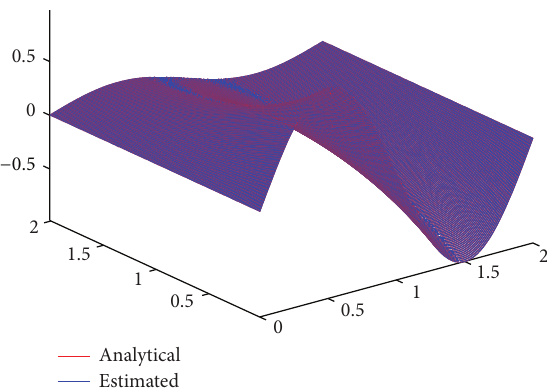
Figure 3: Theoretical solution (red color) and numerical solution (blue color) for Example